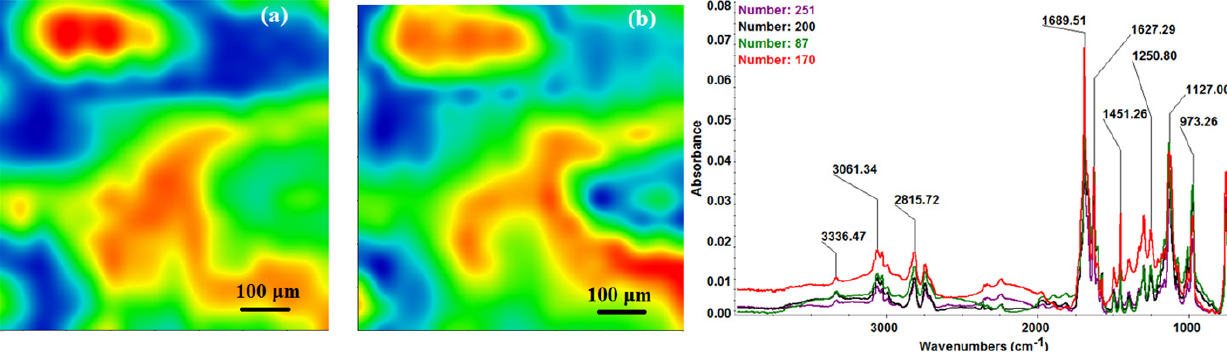
O @CV dropcasted on 3 4 − 1 .